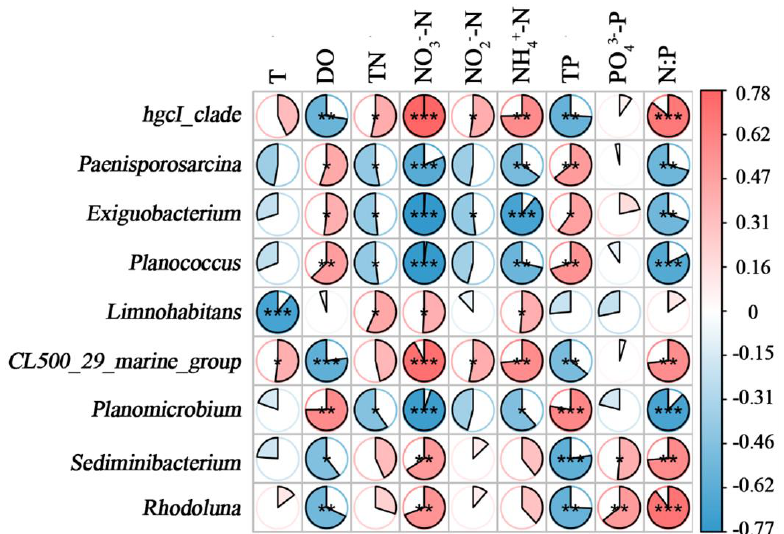
Figure 5. Correlations between microbial communities and water physicochemical factors. Each